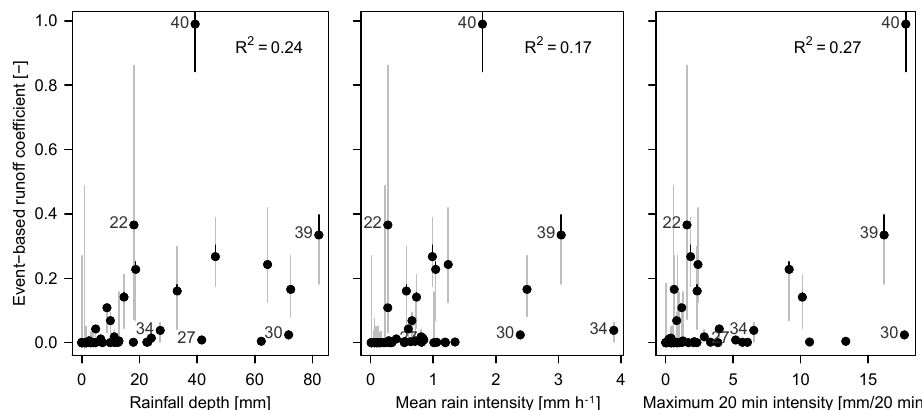
Figure 7. Correlation of three variables describing meteorological forcing with event-based runoff coefficients φ ev of the Gazel catchment calculated with the recursive digital filter method. The lines represent the uncertainty associated with the hydrograph separation method (gray vertical lines: range of φ ev calculated with the seven different methods) and the stage–discharge relation (black vertical lines: range between φ ev calculated with the 5% and the 95% confidence interval of discharge obtained with the BaRatin framework). The point labels give the numbers of selected events as in Tables 3 and 4 and described in the